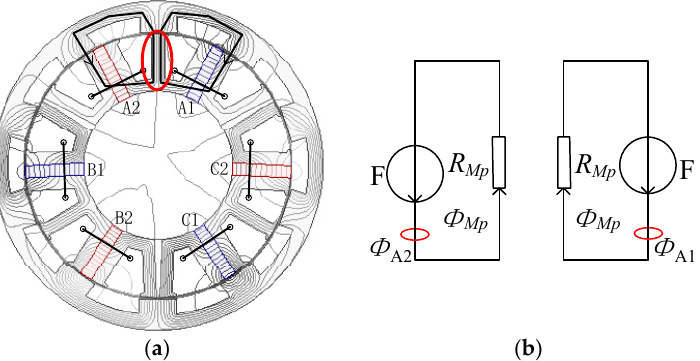
Figure 14. Positive extreme value of phase A flux linkage produced by PMs in MSOR-FSPM motor: ( a ) No-load magnetic field distributions; ( b ) Local equivalent magnetic circuit.